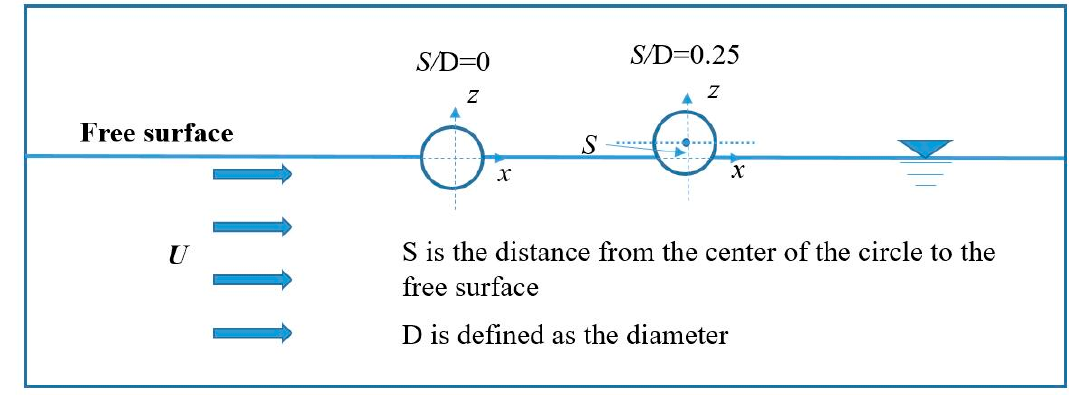
Figure 10. S/D diagram.